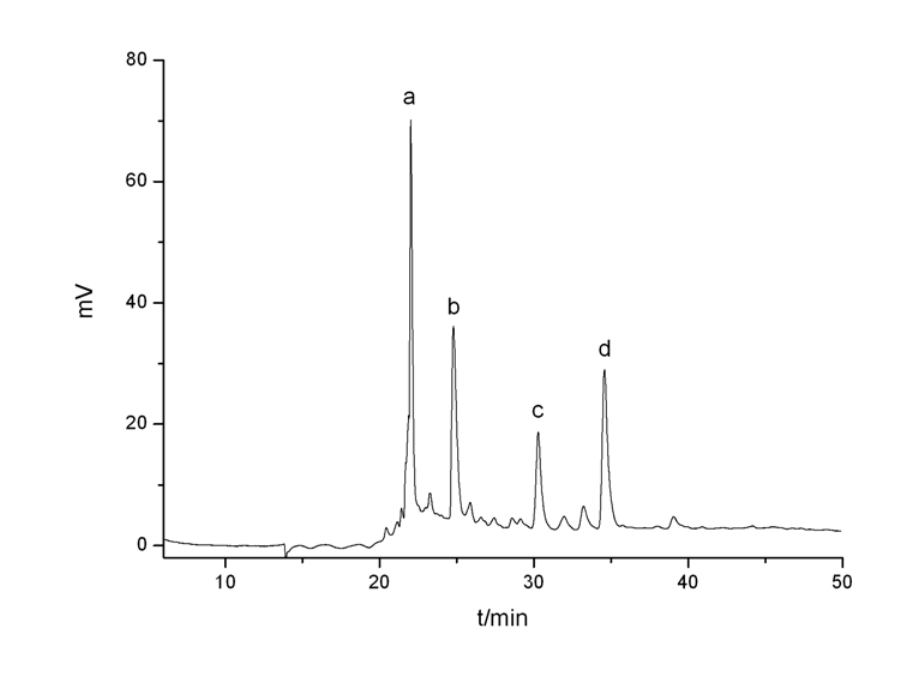
Fig. 9 RP-HPLC profile of crude heptapeptide 1 with serious racemization ( a t R 22.02 min, b t R 24.78 min, c t R 30.27 min, d t R 34.58 min ). According to the t R 24.80